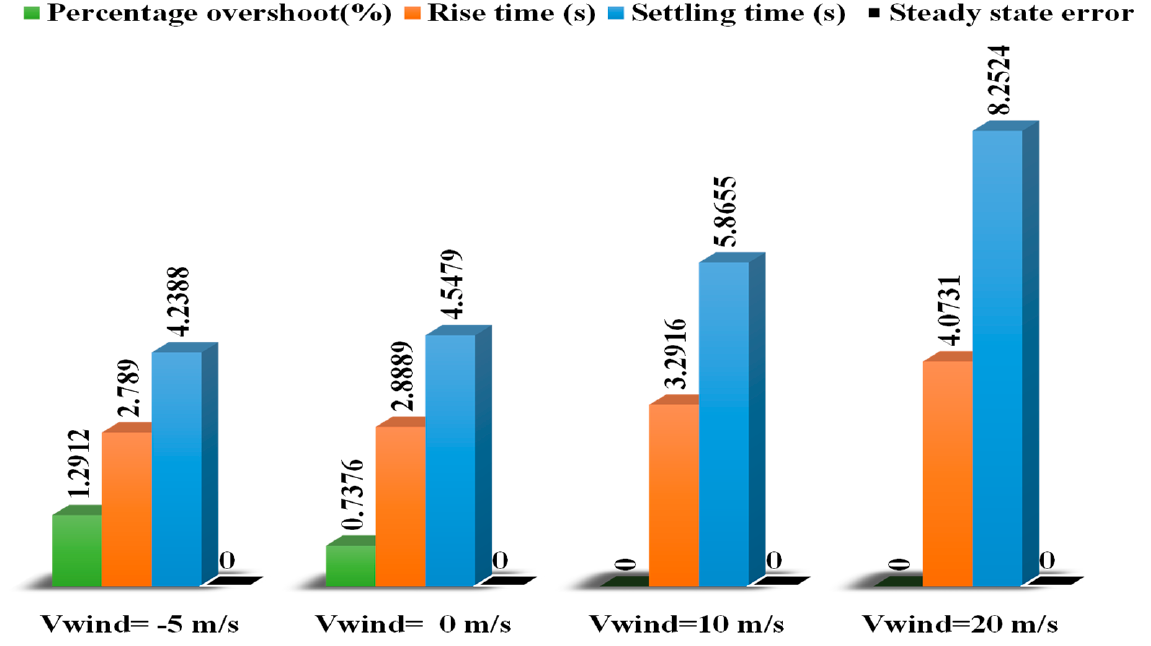
Figure 39. Wind variation effect on BEV performances.